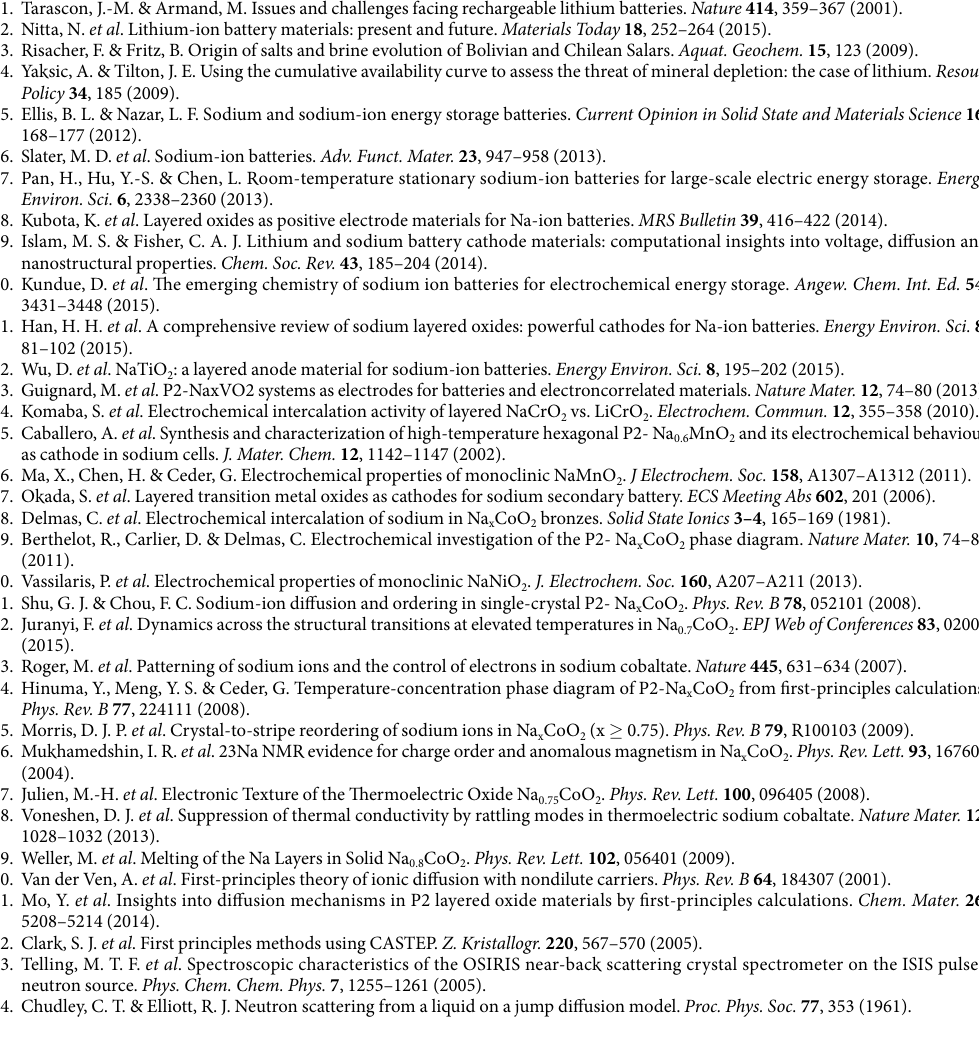
Figshare repository from doi:10.17637/rh.5692846 (MD simulations), doi:10.17637/rh.5692942 (fully ordered stripe phase), doi:10.17637/rh.5692963 (partially ordered stripe phase) and doi:10.17637/rh.5693002 (disordered phase). All raw neutron data and the associated metadata obtained as a result of access to ISIS, reside in the public domain, with ISIS acting as the custodian. The QENS data can be accessed from doi:10.5286/ISIS.E.24090568 (single crystal) and doi:10.5286/ISIS.E.49912250